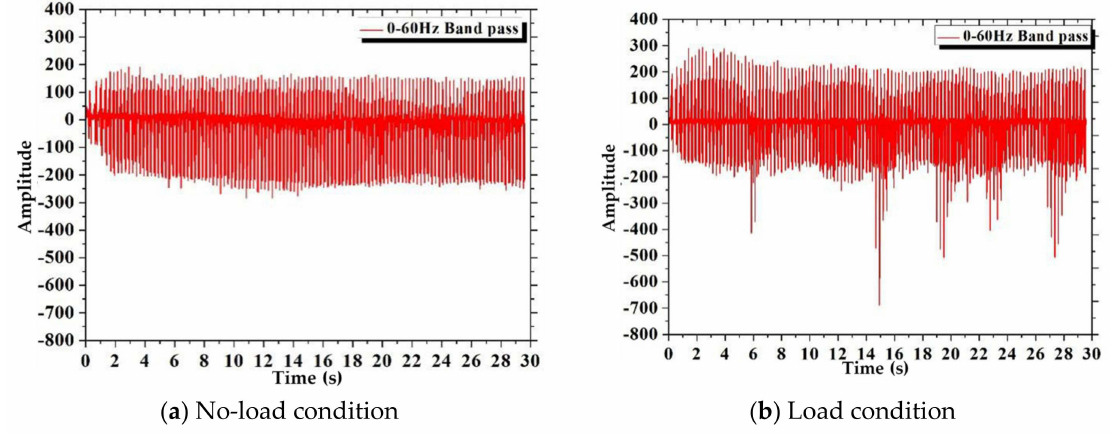
Figure 12. Vibration signals under no-load and load conditions after FFT filtering.